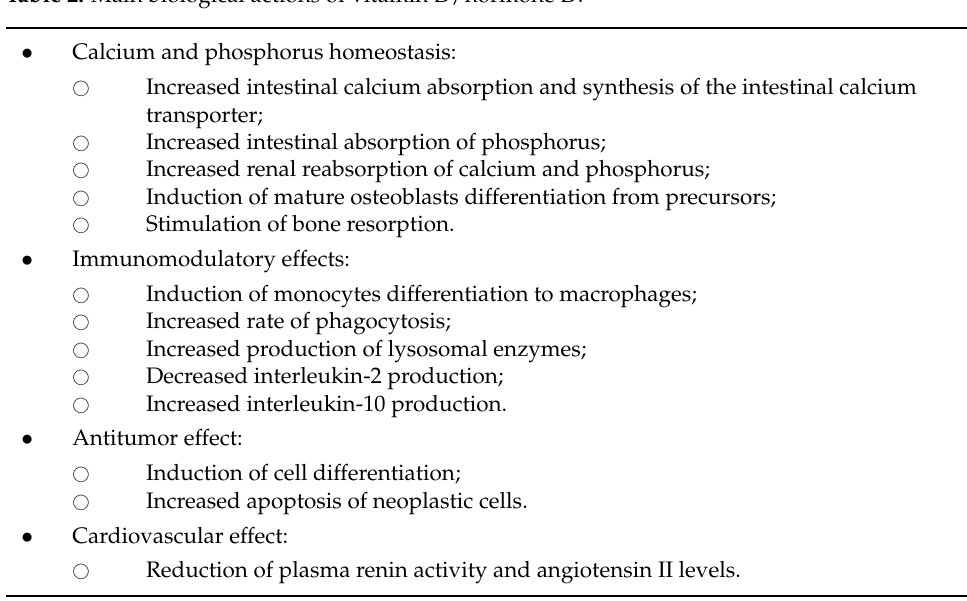
Table 2. Main biological actions of vitamin D/hormone